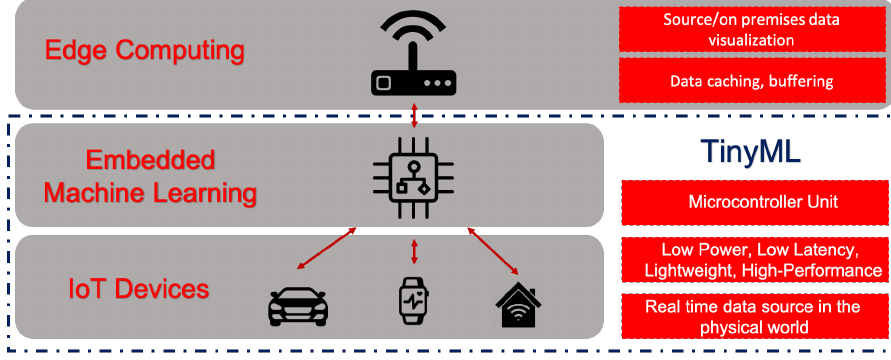
Figure 1. TinyML ecosystem-as-a-service and the use of machine learning at the